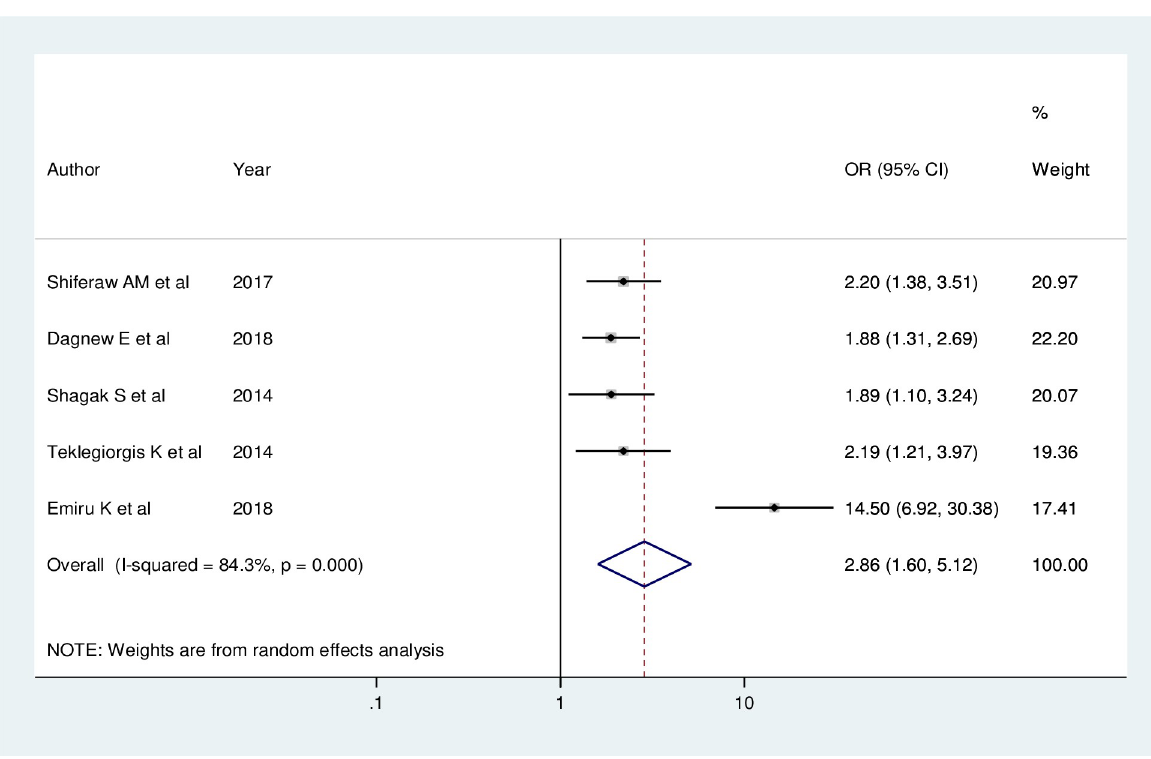
Fig 6. Forest plot showing the pooled odds ratio of the association between regular feedback and utilization of routine health information health workers in Ethiopia, 2020.